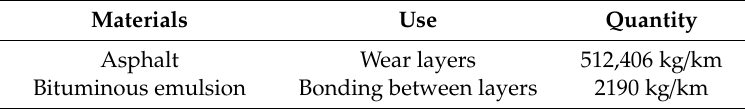
Table 8. The materials required for wear layer